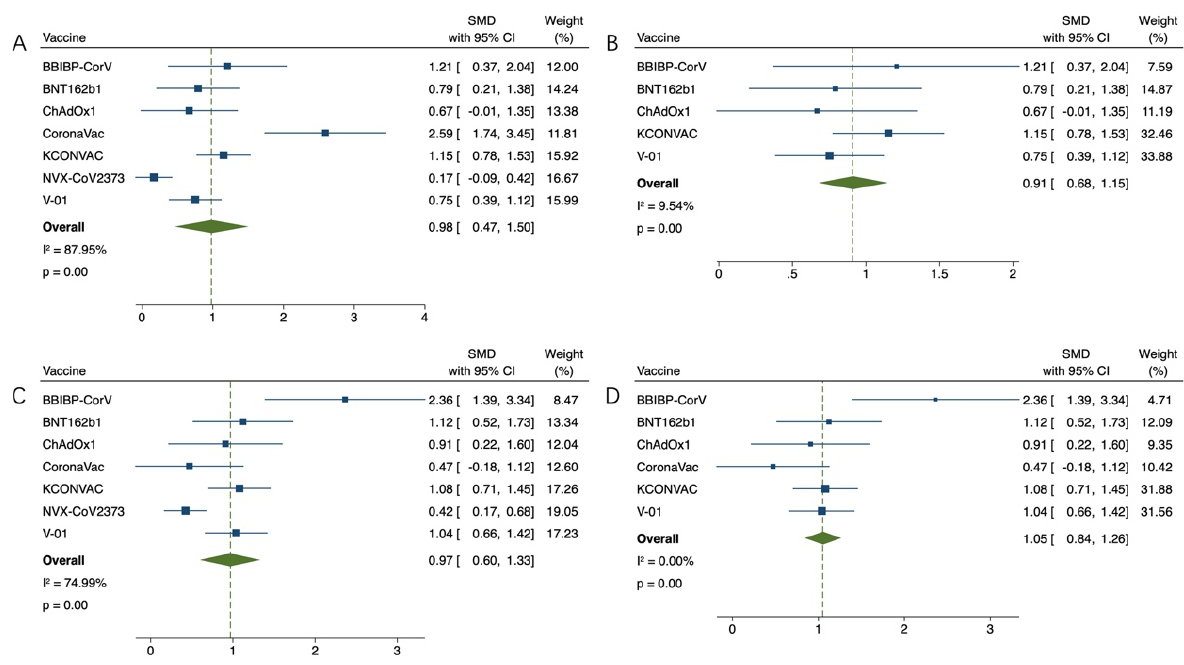
Figure 3. ( A , B ) Meta-analysis of the GMT between the experimental group (older adults) and the control group (placebo) after the first vaccination, and results after reducing heterogeneity. ( C , D ) Meta-analysis of the GMTS of the experimental group (elderly) and the control group (placebo) after the last vaccination, and results after reducing heterogeneity. Blue squares represent effect sizes for a single study, and green rhombus represent pooled results for all studies.